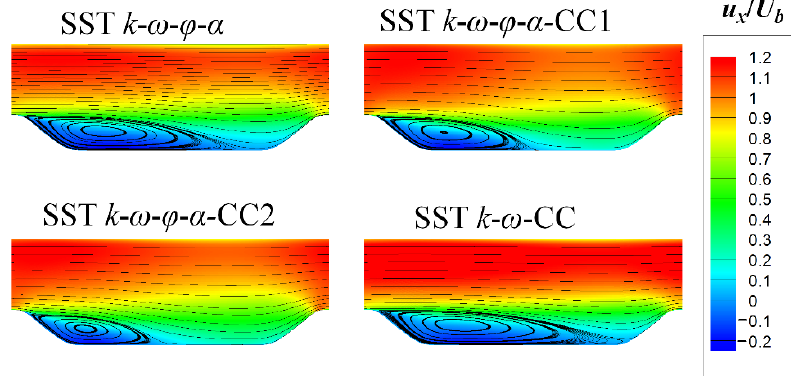
higher peak velocities due to the larger re ‐ circulation zone.